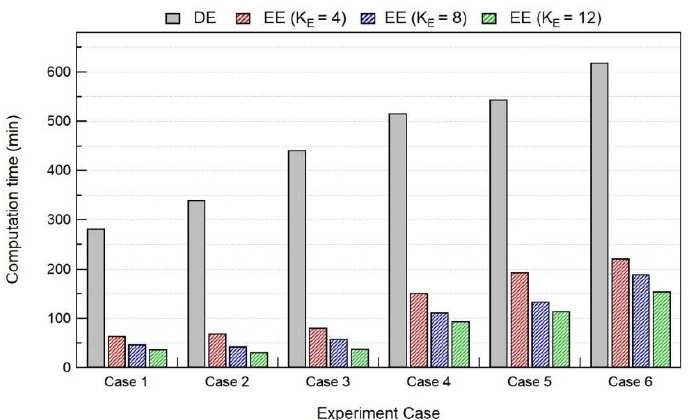
Figure 11. Comparison of computation time for thermal analysis between DE and EE heat sources with different elongated length.